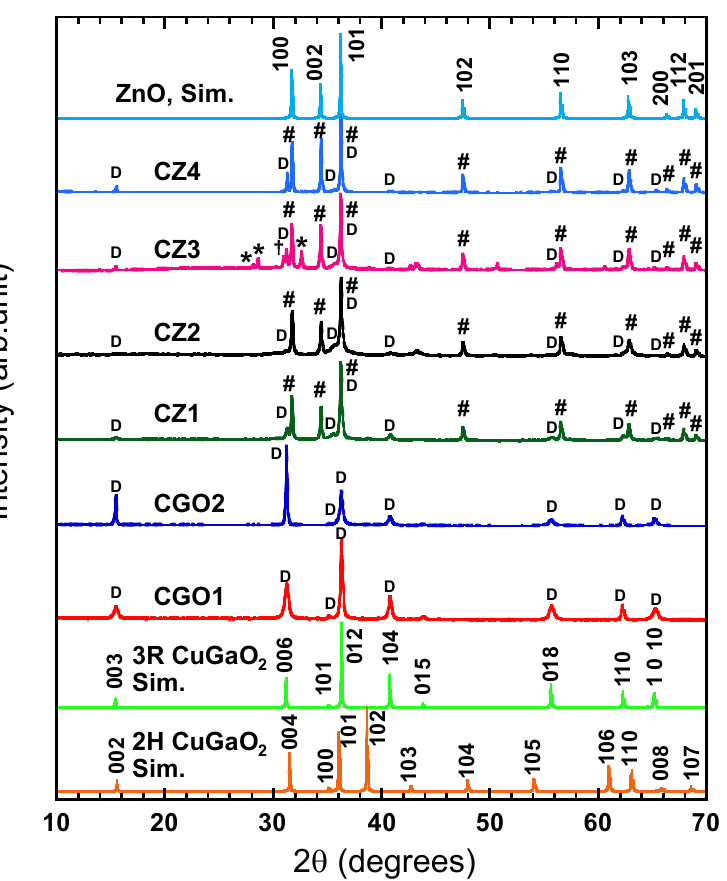
Figure 3. XRD patterns of the CuGaO 2 /ZnO hybrid samples post ‐ annealed in H 2 /N 2 , together with those of the CuGaO 2 base crystals (CGO1 and CGO2) for comparison [9]. The simulated patterns of 3R and 2H CuGaO 2 and ZnO are also shown. The symbols D, #, †, and * indicate 3R CuGaO 2 , ZnO, CuGa 2 O 4 , and ZnCu 2 O 4 , respectively. (See the main text for details.).